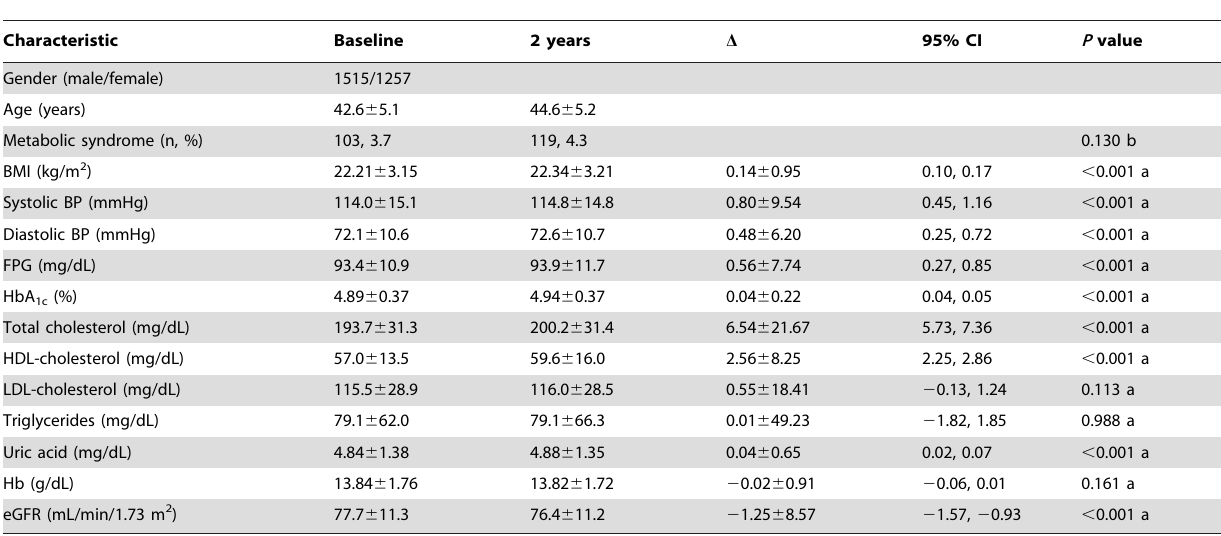
Table 1. Characteristics of subjects at baseline and 2 years.